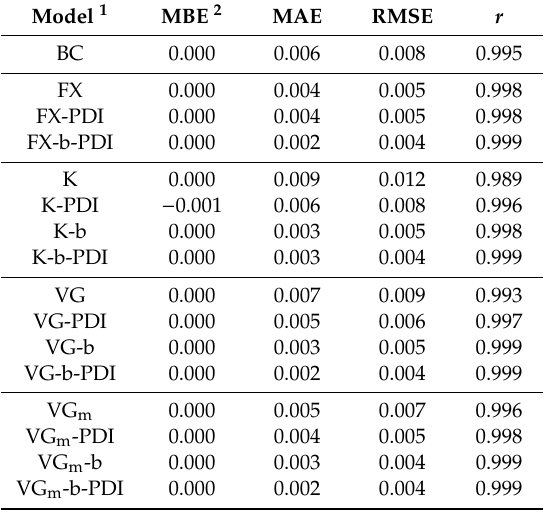
Table 4. Overall performance of the 16 models evaluated in this study for the USA soils. Model 1